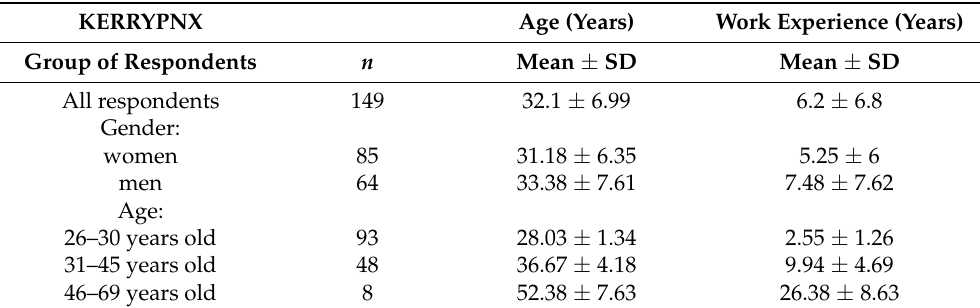
Table 1. Mean and standard deviation of age and work experience and number of respondents in particular age groups and for a given gender, and the number of respondents in each group. KERRYPNX Age (Years) Work Experience (Years) Group of Respondents n Mean ± SD Mean ± SD All respondents 149 32.1 ±